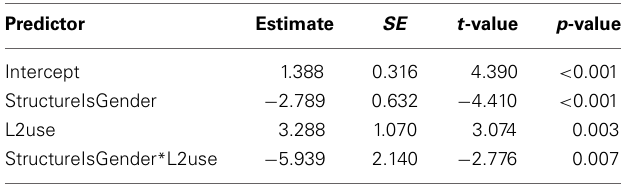
Table 4 | Linear multiple regression model predicting P600